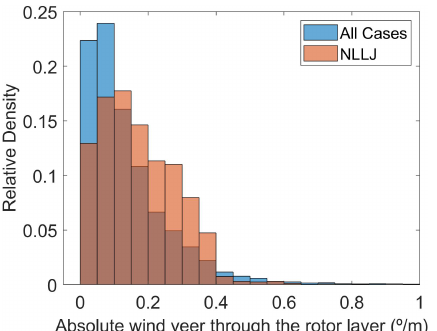
Figure 18. Wind veer in the rotor layer. Shown is the frequency of the absolute wind veer in the mean rotor layer (50–150ma.g.l.) during all nights (blue) and during NLLJs